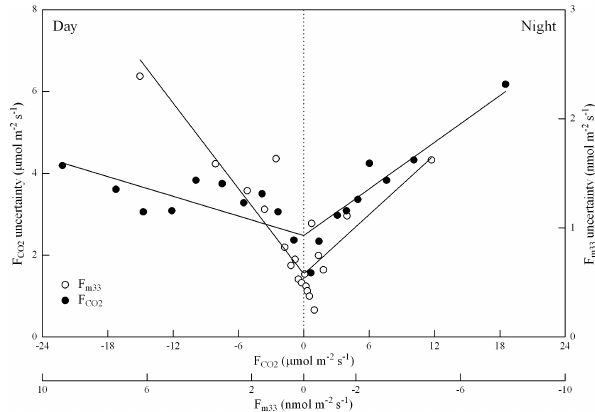
Fig. 5. Random uncertainty of methanol flux (vDEC method) and CO 2 flux (from Haslwanter et al., 2009) derived according to Hollinger and Richardson (2005). Data have been binned into classes of equal size. A double-linear relationship with a common y -intercept was fit to the methanol flux data: y = 0.31 × +0.58 (day- time, R 2 =0.83), y = − 0.22 × +0.58 (nighttime, R 2 =0.71). Note that the x -axis for methanol fluxes was flipped in order to match CO 2 fluxes which are opposite in